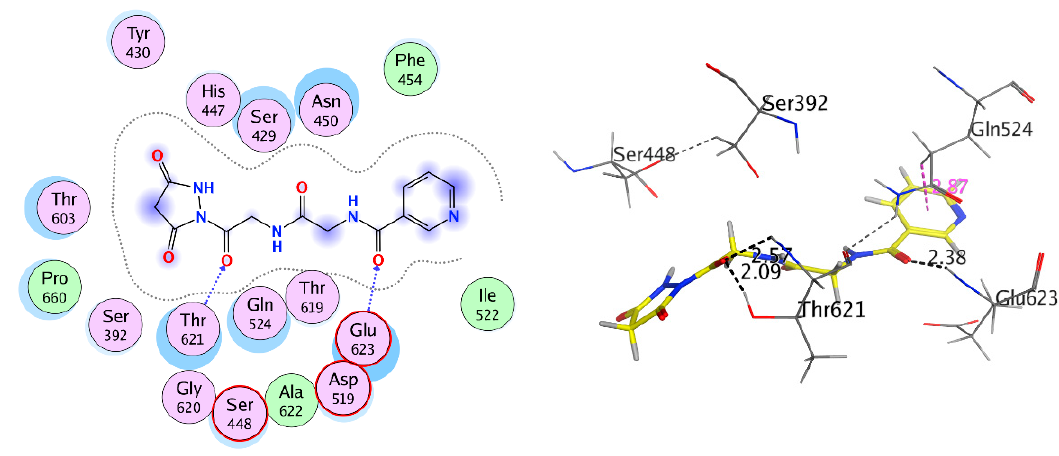
Figure 5. 2D and 3D interaction of compound 8 with 3VSL.